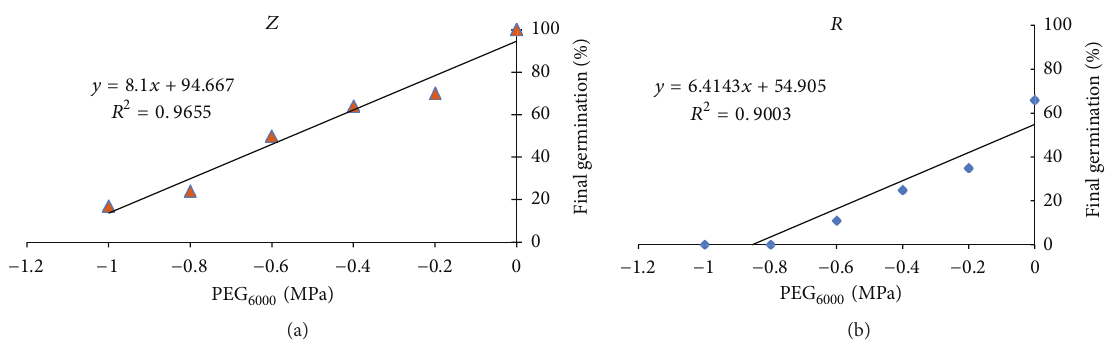
Figure 5: Regression plots for mean final germination percentages of Ziziphus lotus ( 𝑍 ) and Rhus tripartitum ( 𝑅 ) seeds at different PEG 6000 concentrations. Values ( 𝑛 = 100 ) are from the six treatments with five